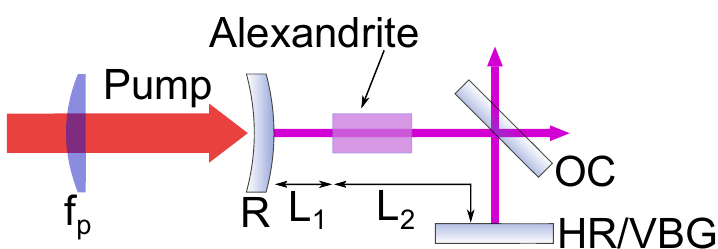
Figure 3. Three-mirror convex-plane cavity with single-end-pumping